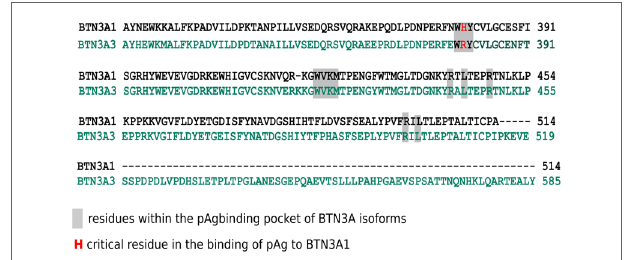
FiGURe 2 | Alignment of the intracellular B30.2 domain sequences of BTN3A1 and BTN3A3 isoforms. Amino acid sequence alignment of the B30.2 domains of BTN3A1 (top line) and BTN3A3 (bottom line). Dashes indicate absent residues in BTN3A1. Amino acids are shown in the single letter designations and numbered according full length nomenclature. Gray boxes indicate residues which constitute the pAg-binding positively charged pocket. Red font highlights the single amino acid difference between pAg-binding pocket, in position 381, H in BTN3A1, and R in BTN3A3 isoforms adapted from Ref.